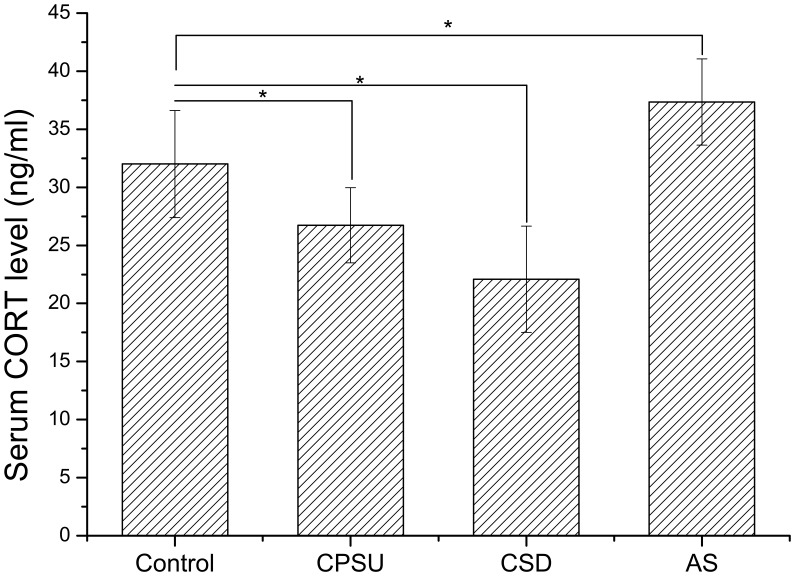
Serum corticosterone (CORT) level analysis of the animals received different treatments.The serum CORT levels of CPSU and CSD groups were markedly lower than control group. Acute stress (AS) resulted in a significant increase in the plasma CORT level compared to control group. * P<0.01, compared to control group. n = 9 per group.